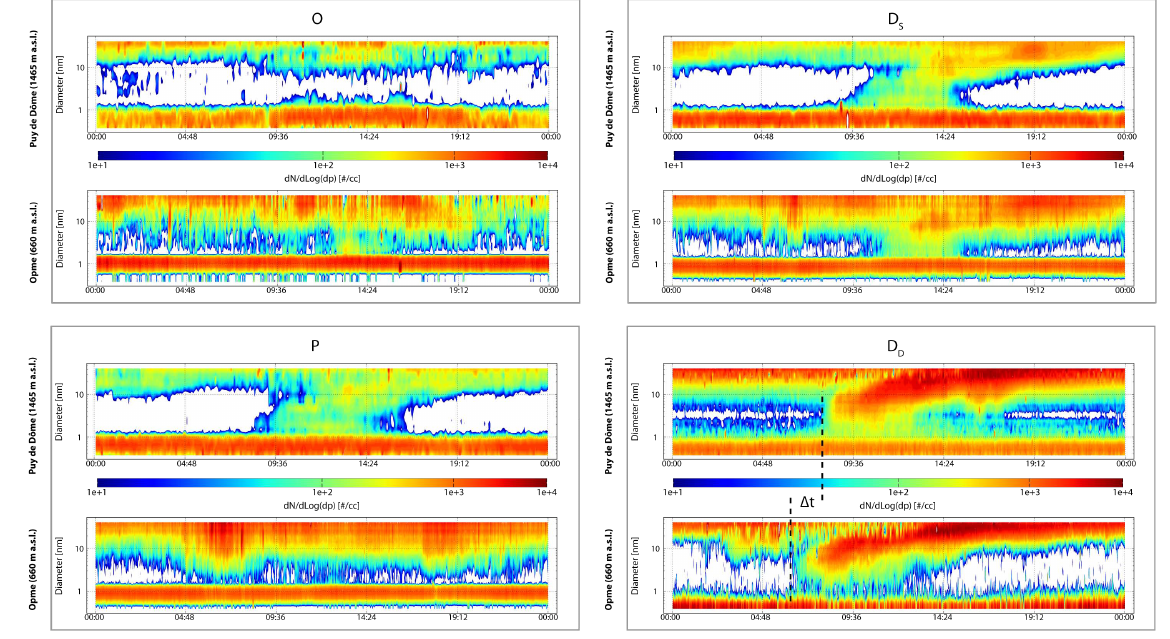
Fig. 5. Average temporal evolution of the negatively charged particle size distribution for the puy de Dˆome (upper panels of grey boxes) and Opme (lower panels of grey boxes) in case of “O” events (upper left box), “P” events (lower left box), “D S ” events (upper right panel) and “D D ” (lower left